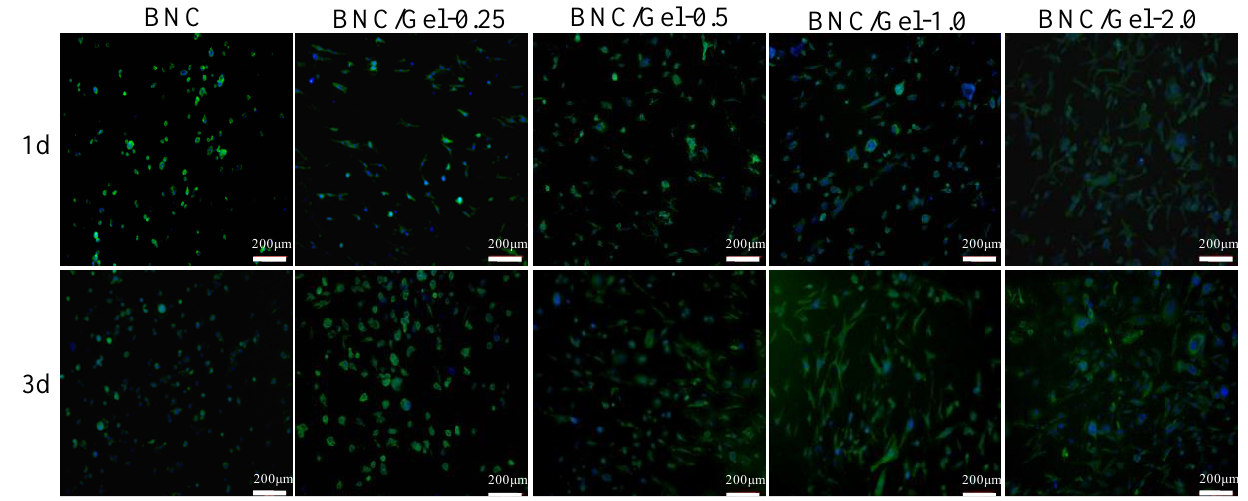
Figure 9. The fluorescence images of HSMCs grown on the surfaces of samples.